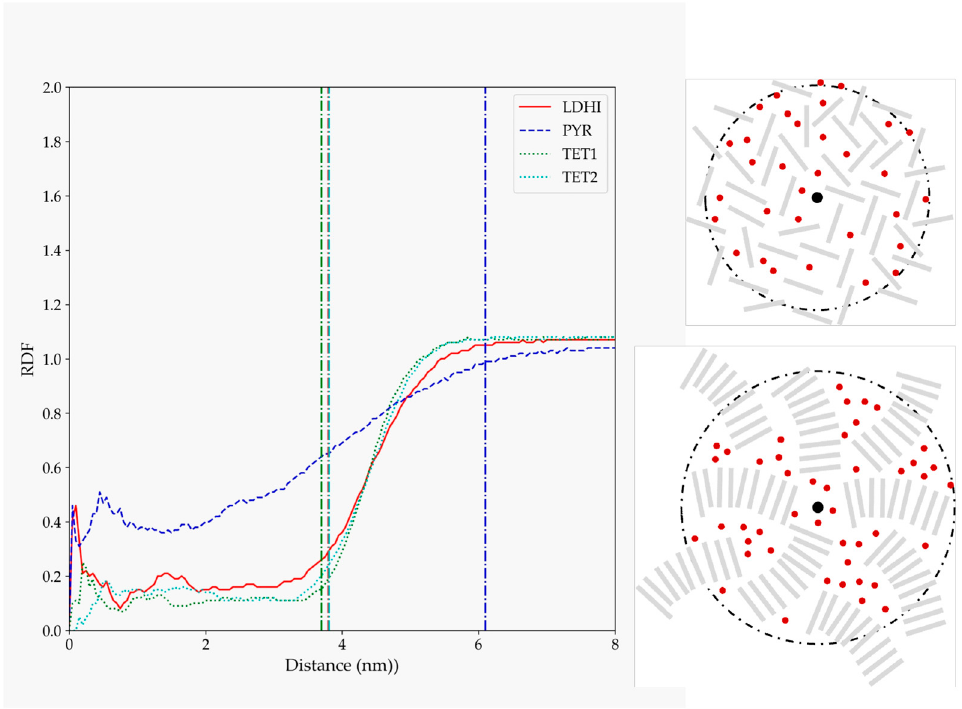
Figure 6. RDF for water atoms relative to the position of the nanosphere center of mass for the four models considered in explicit solvent ( l DHI: red; PYR: blue; TET-1: green; TET-2: cyan). All the profiles are averaged for the three configurations generated for each model. The vertical lines indicate the average approximate value of the radius of gyration for each of the systems. The schemes on the right are simplified depictions for the water penetration proposed for l DHI, TET-1, and TET-2 ( top ), and for PYR ( bottom ) from the overall geometry and the RDF profiles.